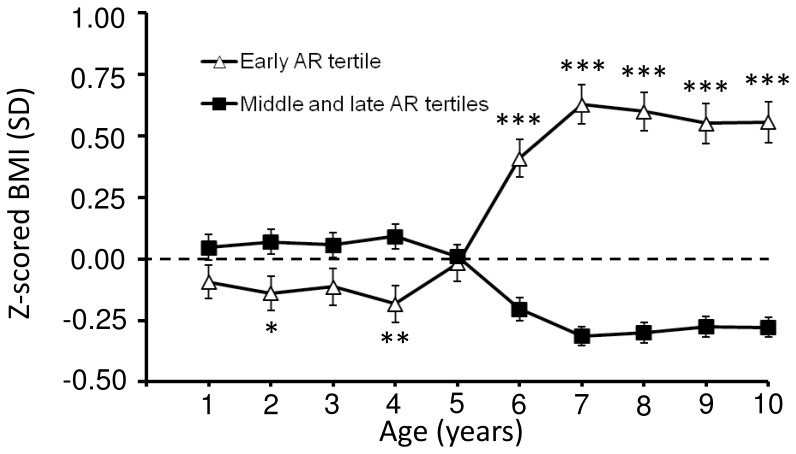
Standardized childhood BMI for early age at AR versus middle and late age at AR.Values are given as Z-score (SD) means ± SEM. BMI = Body Mass Index, AR = Adiposity rebound. *p<0.05, **p<0.01 and ***p<0.001 vs. middle and late tertiles.